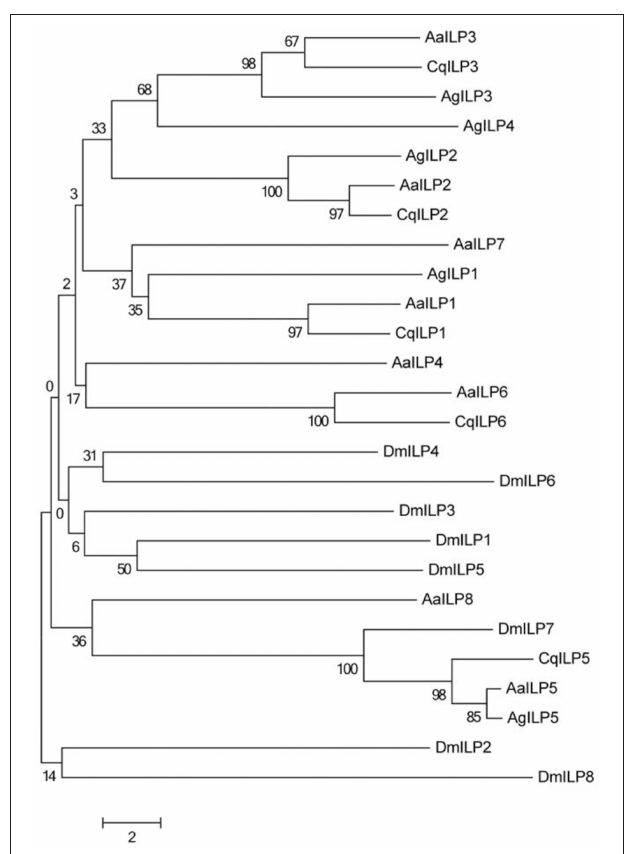
FIGURE 2 | Neighbor-joining tree of mosquito ILP A and B chain amino acid sequences comparing Ae. aegypti (Aa), C. quinquefasciatus (Cq), A. gambiae (Ag), and D. melanogaster (Dm). Tree was constructed using MEGA version 6 (34).